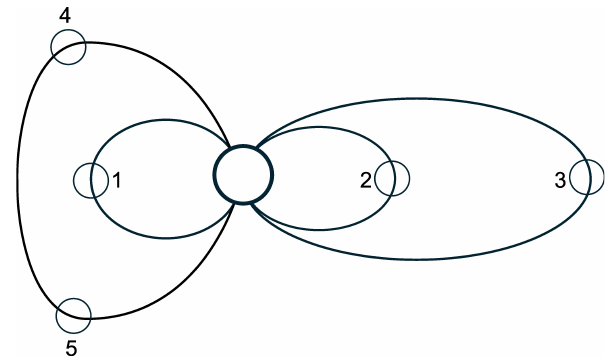
Fig. 2. Cartoon showing possible locations of opaque regions for poloidal Alfv´en waves in the